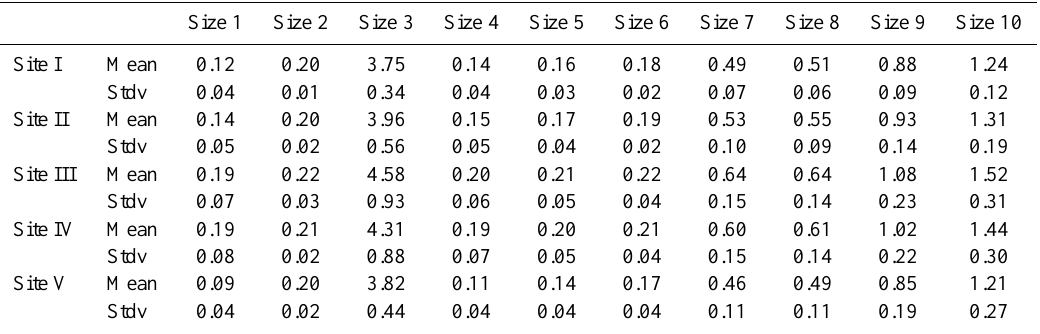
Table 3. Modeled deposition velocities (mean and standard deviation,cms − 1 ) for 10 particle size distributions listed in Table 2 at the five